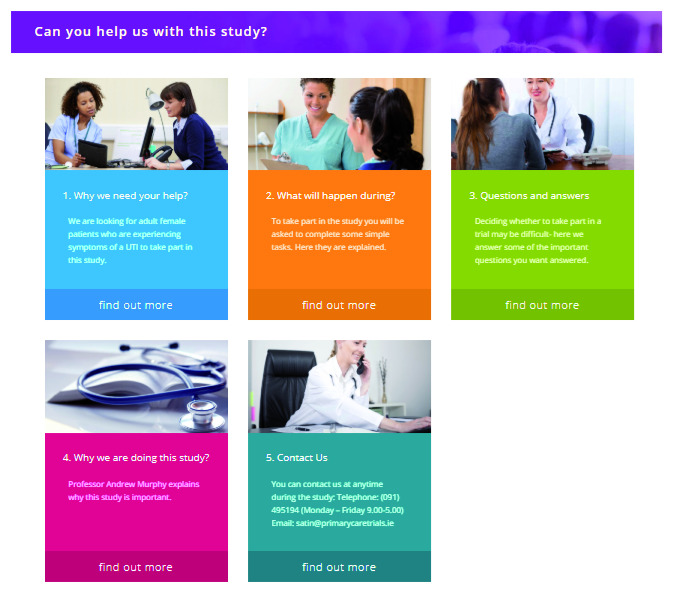
Website template.